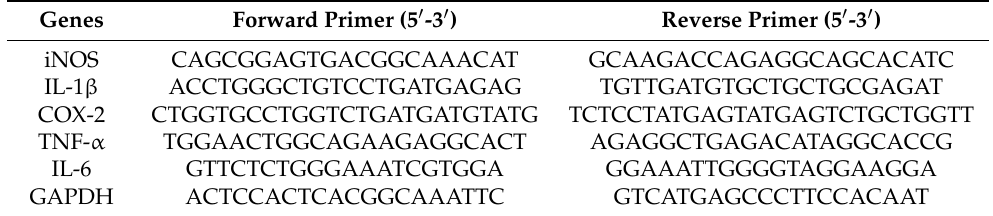
Table 1. Sequences of Real-time PCR